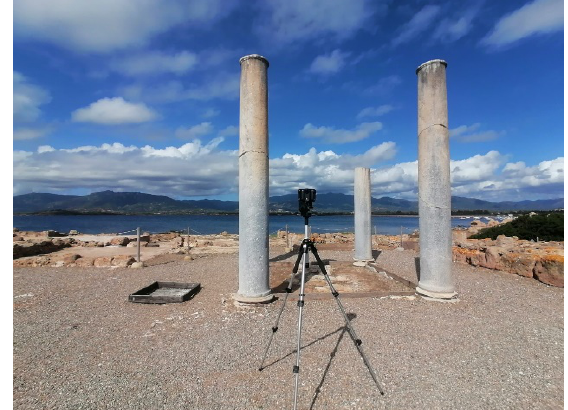
Figure 5. Kandao Obsidian R 8K camera positioned along the tourist route of the